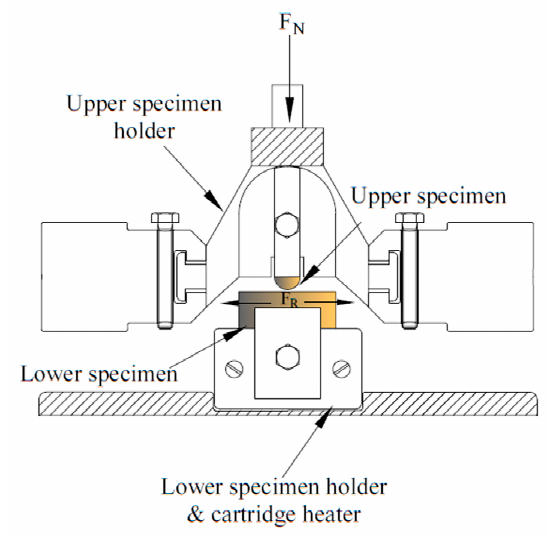
Figure 2. Setup for the wear measurement.